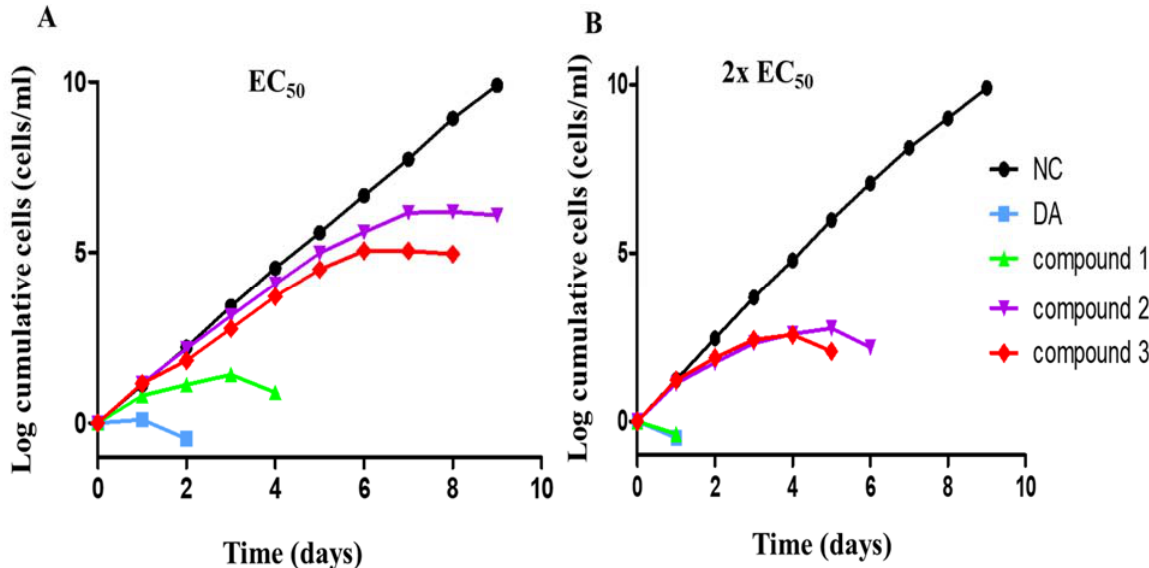
Figure 2. Compound sensitivity analysis in T. brucei : The growth kinetics of T. brucei was investigated after treatment with diminazene (DA), compounds 1 , 2 and 3 for 9 days at EC 50 and 2 × EC 50 . NC = negative control.